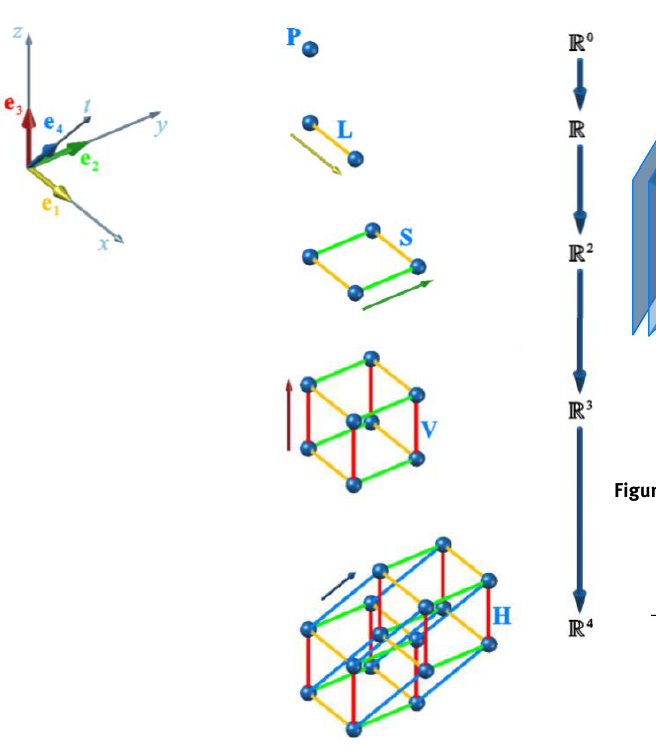
Figure 65: Inductive construction of a 4D hyperprism from dimen- sion 0 to dimension 4, by adding one dimension at a time.